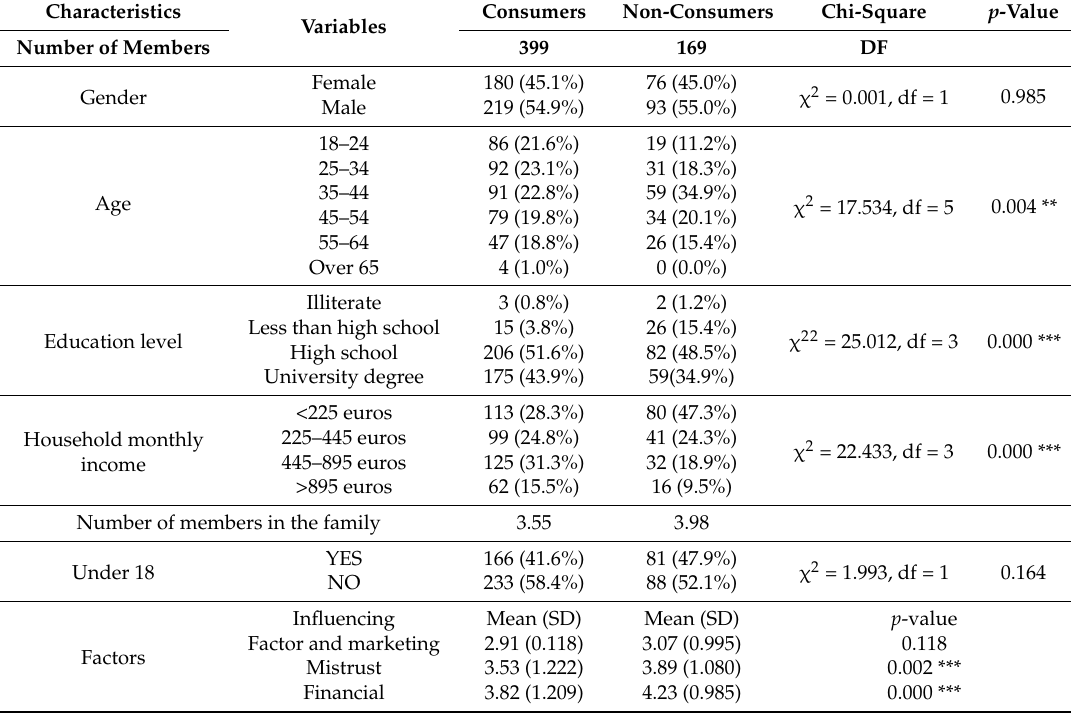
Table 5. Consumers versus non-consumers of organic